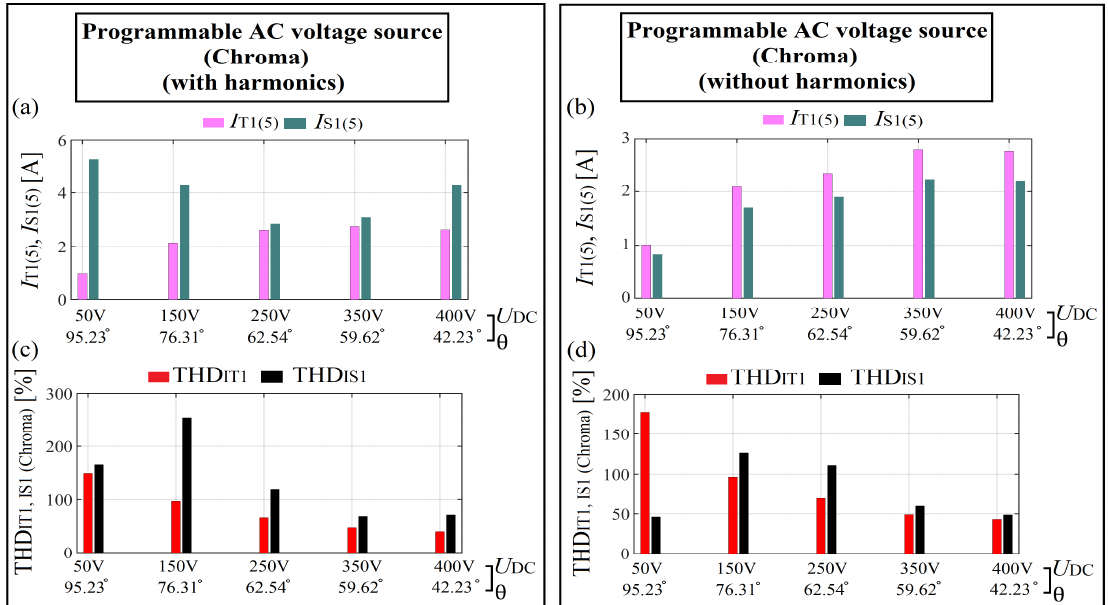
Figure 30. ( a , b ) The amplitude of the 5th harmonic current measured at the load input ( I T1(5) ) is compared to the one measured at the Chroma voltage source input ( I S1(5) ); ( c , d ) the THD of the load input current (THD IT1 ) is compared to the one of the Chroma input currents (THD IS1 ).